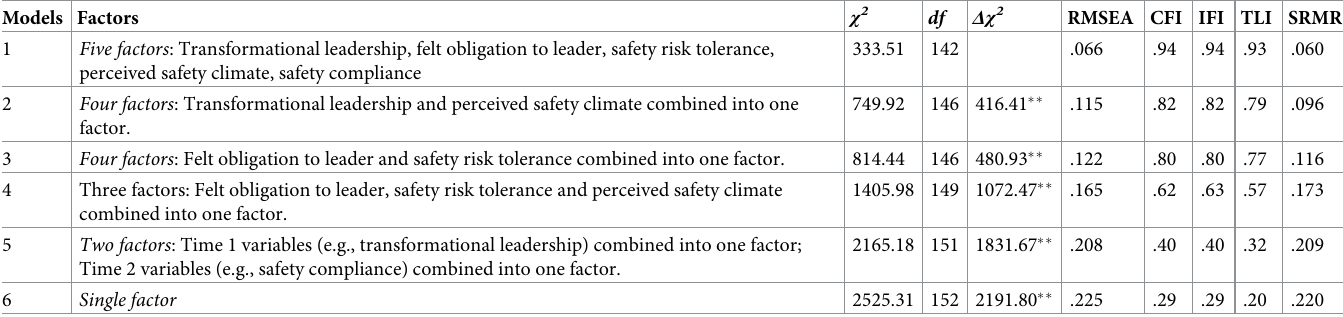
Table 1. Comparison of measurement